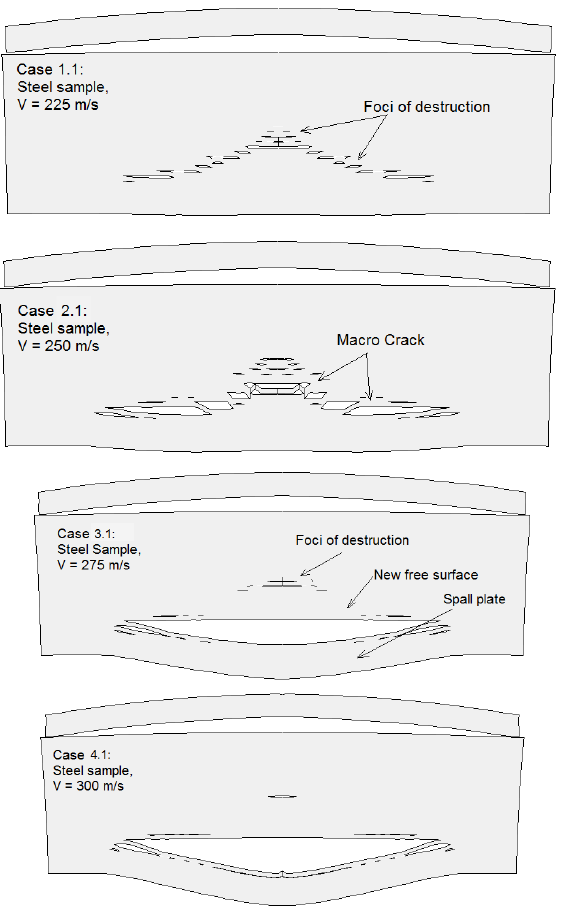
Fig. 5 . Steel samples after impact at t = 0.20 µs. Arrows indicate foci of destruction, new free surfaces, macro cracks and spall